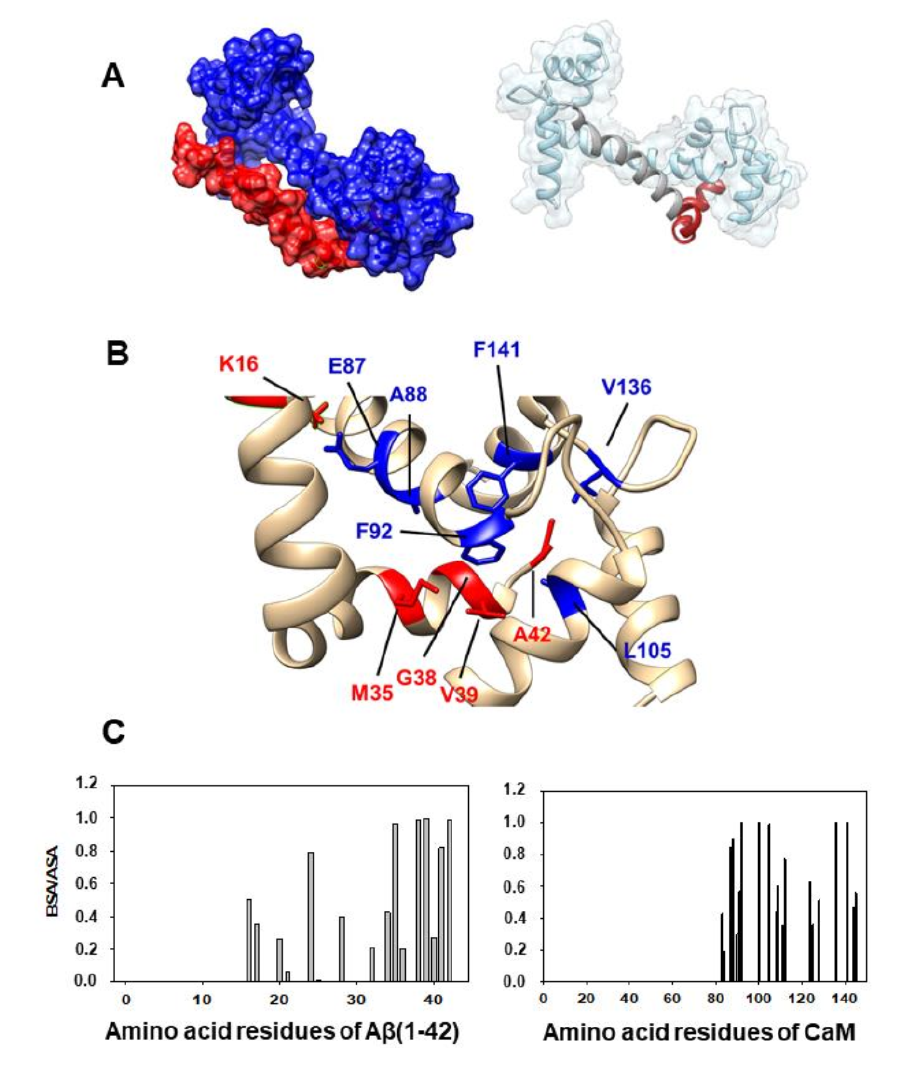
Figure 3. The selected in silico model structure 2 of the complex A β (1–42):CaM obtained using the PDB ID files: 1IYT for A β (1–42) and 1CLL for Ca 2+ -saturated CaM. Docking was performed as indicated in the Materials and Methods section. ( A ) The space-filled and peptide and protein backbone images of the complex. A β (1–42) is stained in red and CaM is stained in blue in the space- filled image. The protein backbone of CaM is stained in light blue, the 24–42 amino acid residues of A β (1–42) are stained in red, and the rest of the A β (1–42) is stained in dark grey. ( B ) The structural details of the A β (1–42):CaM interface of in silico model structure 2. The CaM amino acid residues (colored in blue) more strongly interact with the 24–42 amino acid residues of A β (1–42) (colored in red). ( C ) Graphic charts of the BSA/ASA values obtained for the amino acids residues of A β (1–42) and CaM in the in silico model structure 2 of the A β (1–42):CaM